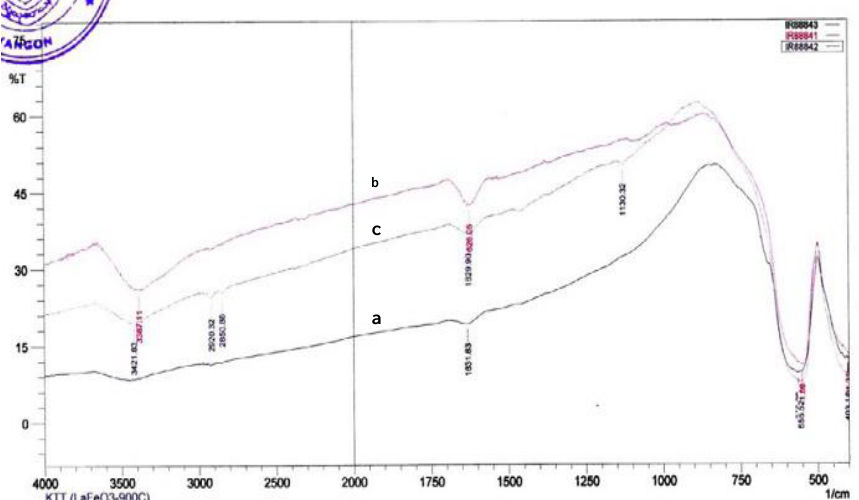
Figure 7. FT IR spectra of LaFeO ₃ nanocrystalline particles sintered at (a) 800 ˚C, (b) 900 ˚C and (c) 1000 ˚C